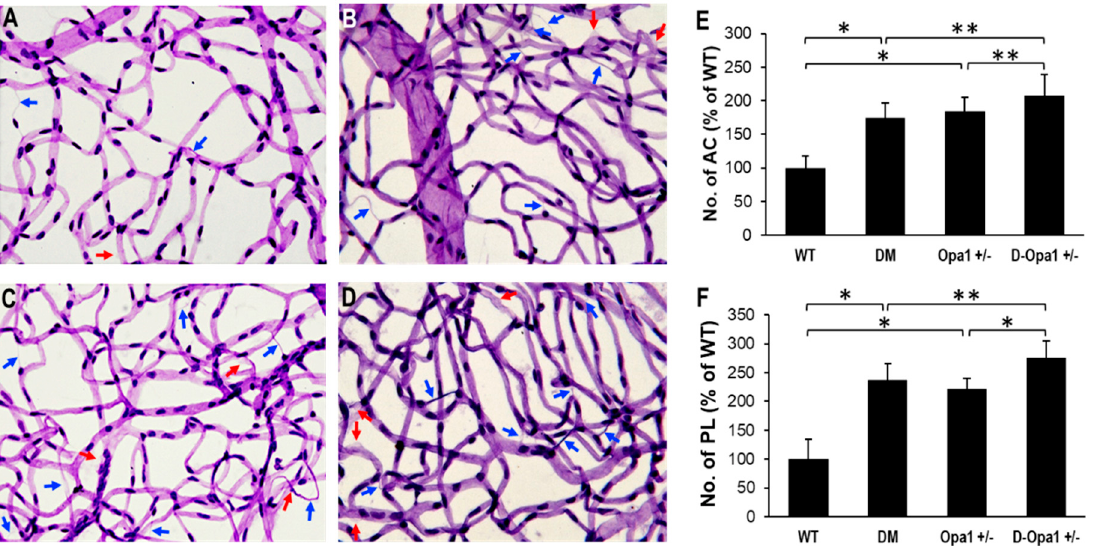
Figure 6. Effects of diabetes or decreased Opa1 level on AC and PL development in mouse retinas. ( A – D ) Representative images of retinal capillaries from ( A ) WT, ( B ) DM, ( C ) Opa1 +/ − , and ( D ) D- Opa1 +/ − mice show an increased number of AC (blue arrows) and PL (red arrows) in the diabetic mouse retina compared with those of the control mouse retina; 40x magnification. Importantly, the number of AC and PL is increased in retinas of D- Opa1 +/ − mice compared with that of diabetic mice. Graphical illustrations of cumulative data show reduced Opa1 levels in the D- Opa1 +/ − mouse retina exacerbates the development of ( E ) AC and ( F ) PL. Data are expressed as mean ± SD. * = p < 0.01, n = 12; ** = p < 0.05, n = 12.